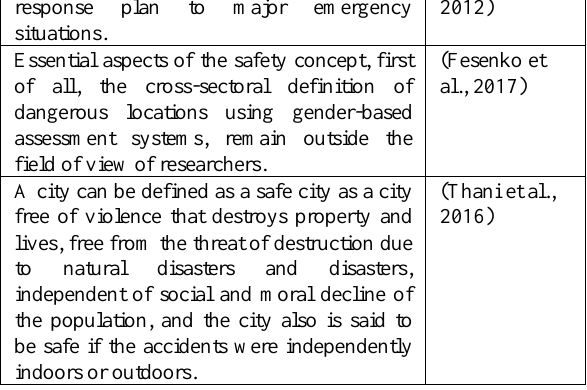
Table 1. Definition of Safe City Concept